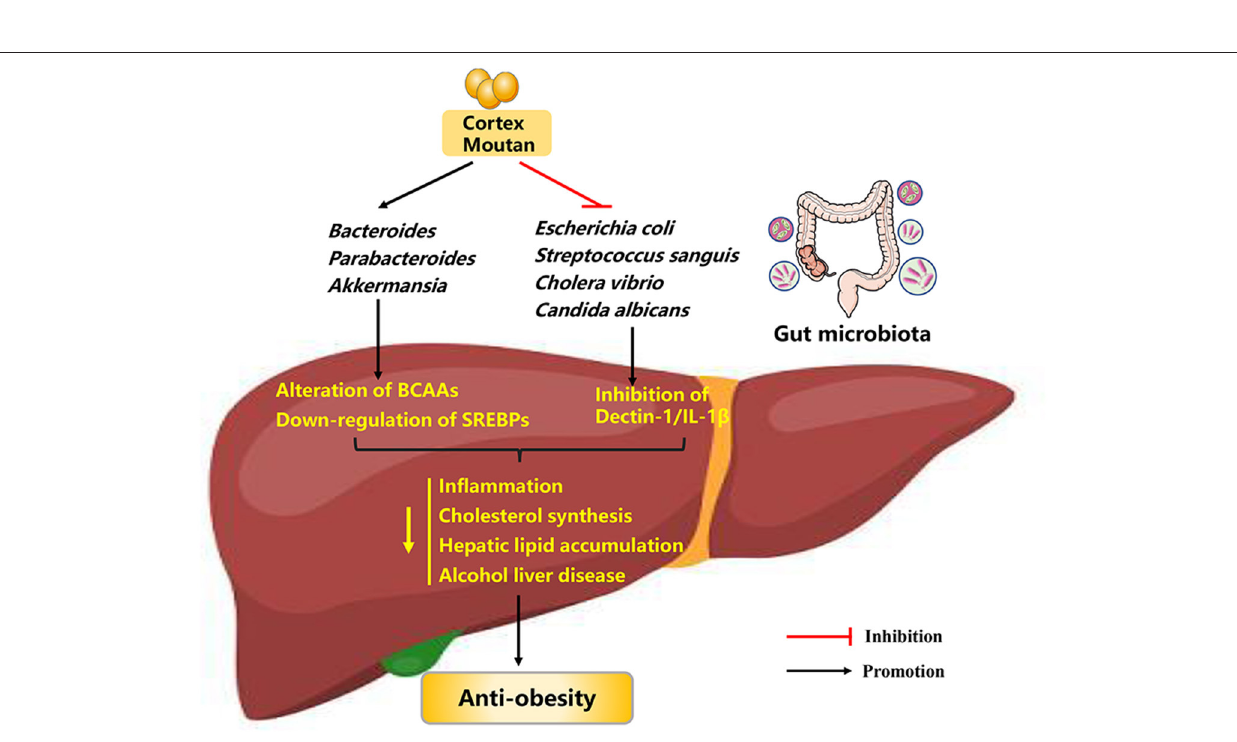
Frontiers in Nutrition |